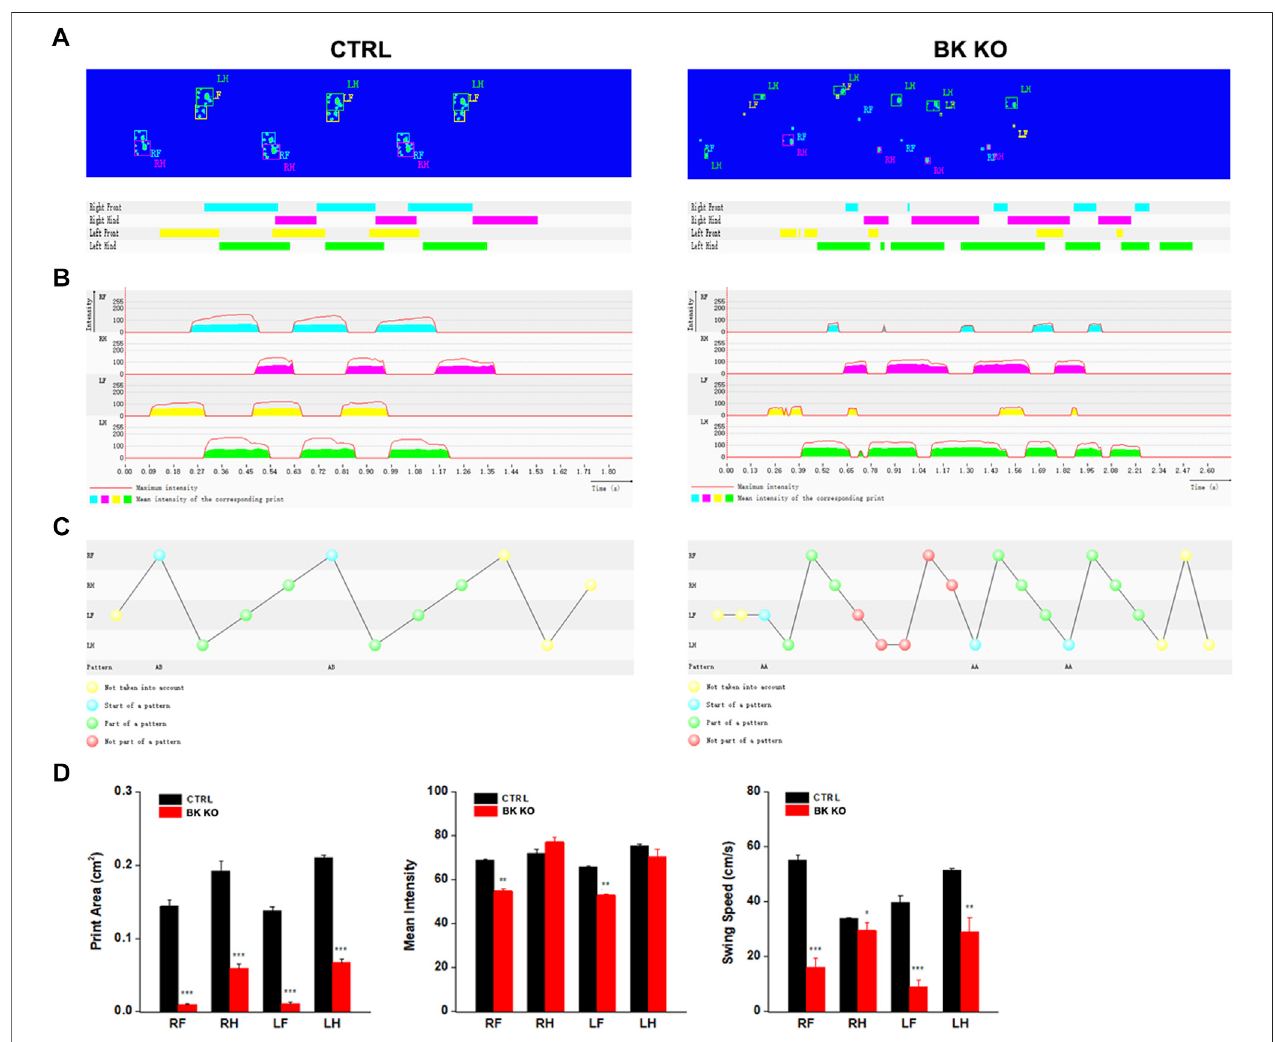
FIGURE 7 | Gait analysis was performed by DigiGait imaging system. (A – C) Schematic diagram of WT and BK KO mouse footprints. (D) Print area (cm 2 ), mean intensity and Swing speed (cm/s) of the right front (RF), the right hind (RH), the left front (LF), the left hind (LH) limb were chosen as the observation index. The Data are presented as means ± SEM. (Compared with control group, * p < 0.05, ** p < 0.01, *** p < 0.001, n (cid:2) 5).